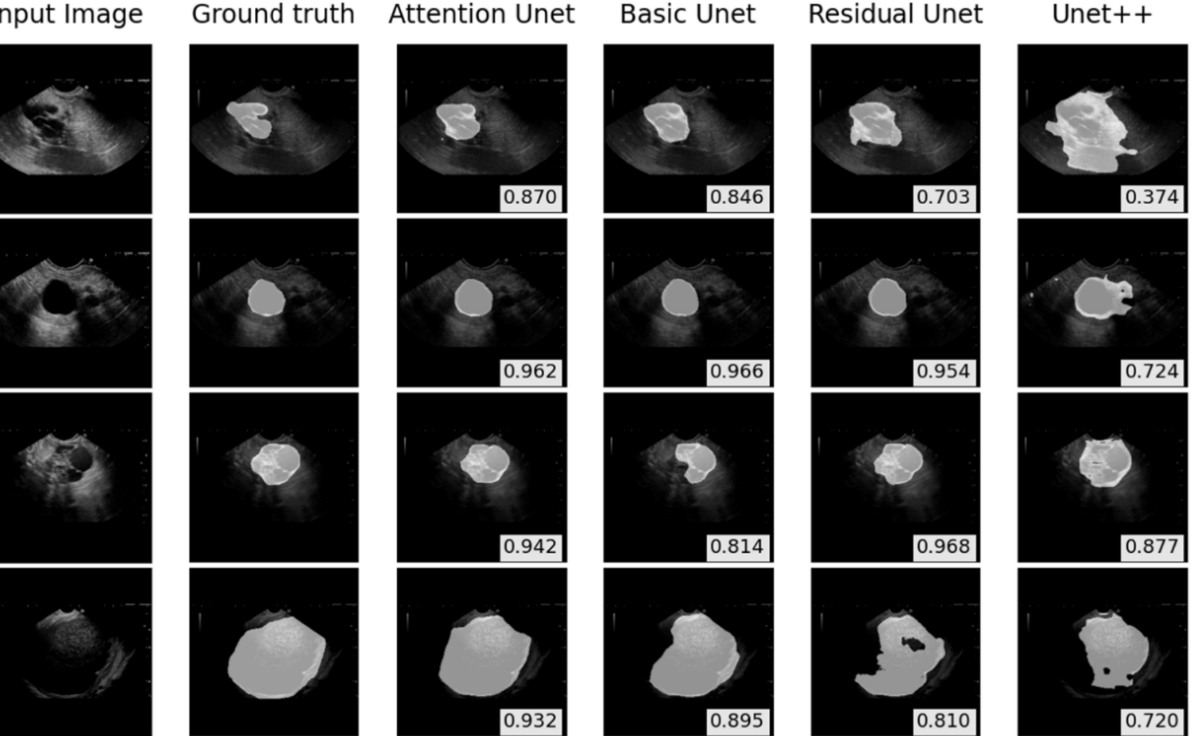
Figure 3. Comparison of the internal test with Boxplot representation and Wilcoxon test results be- tween the deep-learning algorithms. ( a ) Boxplot representation and Wilcoxon test results of dice similarity score (DSC) and ( b ) Boxplot representation, and Wilcoxon test results of intersection over union score (IoU). ns: not significant, *: p -value < 0.05, **: p -value < 0.01, ***: p -value < 0.001, Number of images ( n ) = 14.